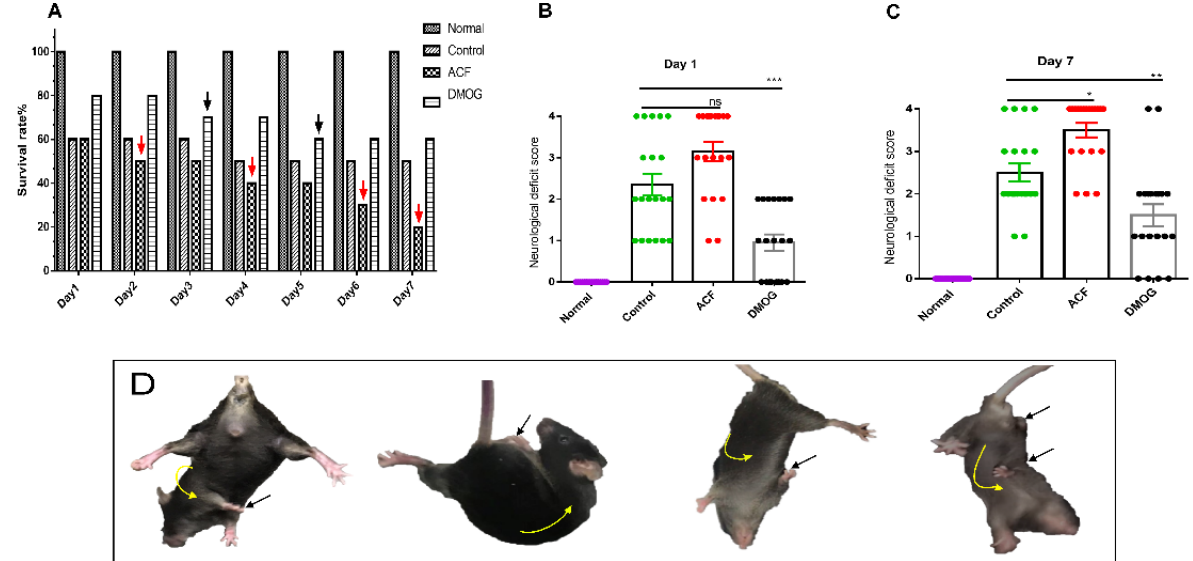
Figure 1. HIF-1 α activation improves the neurological outcomes following ET-1 injection. ( A ) Survival rate %; DMOG group displays a higher survival rate, ( B ) Neurological deficit score Day 1: ACF vs. Control p = ns; DMOG vs. Control *** p < 0.001 ( C ) Neurological deficit score Day 7: ACF vs. Control * p < 0.05; DMOG vs. Control ** p < 0.01. ( D ) Represent the different observed neurological deficits. All values are expressed as mean ± SEM, One-way ANOVA with post hoc Tukey test, n = 20.